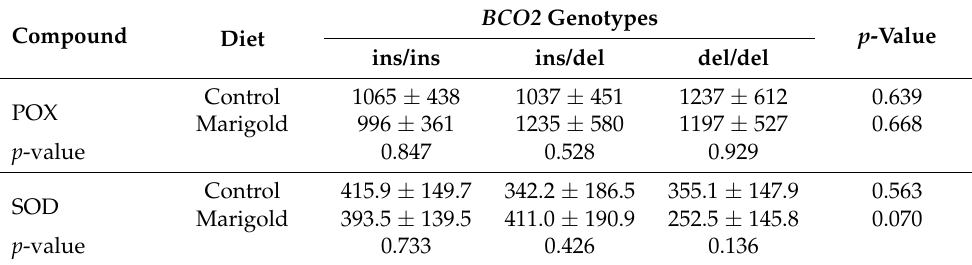
Table 4. Activity of antioxidant enzymes in the blood serum (IU/mL) of rabbits.